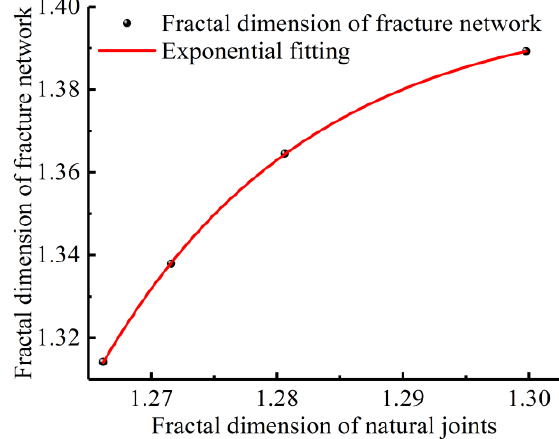
Figure 13. The fractal dimension variation of fractured fracture in CBM reservoir under different fractal dimensions of natural joints.